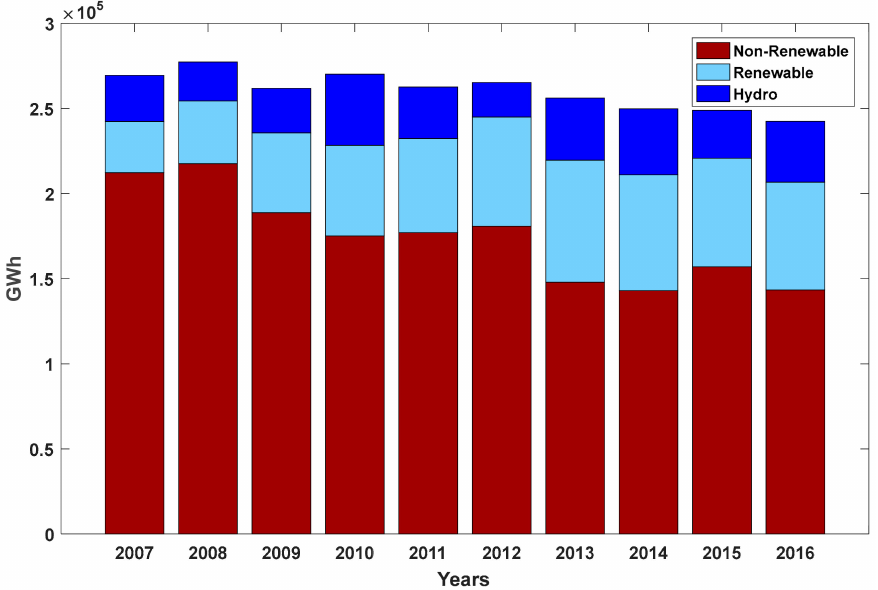
Figure 2. Overview of renewable (with a hydropower classification) and nonrenewable energy production in Spain (data were obtained from